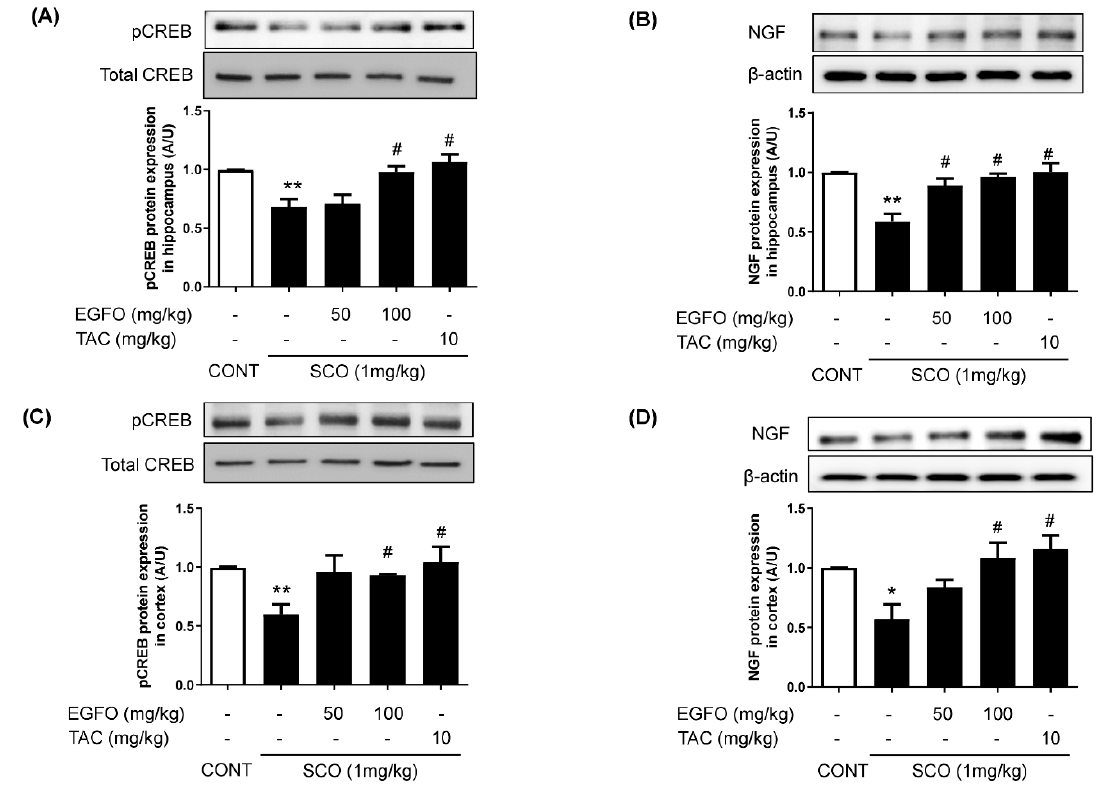
Figure 4. EffectofEGFOextractonphospho-CREBandNGFlevelsinmicewithscopolamine-induced memory impairments . Hippocampal and cortical tissues were homogenized and performed Western blotting with anti-phospho-CREB or NGF antibodies. Levels of phosphor-CREB (A , C ) and NGF ( B , D ) expression in hippocampus and cortex were normalized by total CREB or β -actin, respectively. Bar graphs represent the relative intensity in each band. Values are expressed as the mean ± SEM. ( n = 7 / group). * p < 0.05, ** p < 0.01 vs. CONT group, # p < 0.05 vs. SCO group. CREB: cAMP response element-binding protein; NGF: Nerve growth factor; CONT: Normal control; SCO: Scopolamine; EGFO: Elaeagnus glabra f. oxyphylla ; TAC: